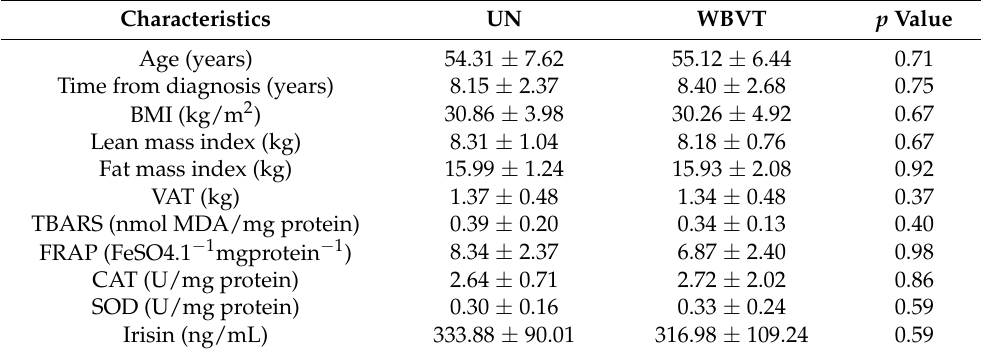
Table 2. Clinical, anthropometric, and blood biomarker characteristics of participants at